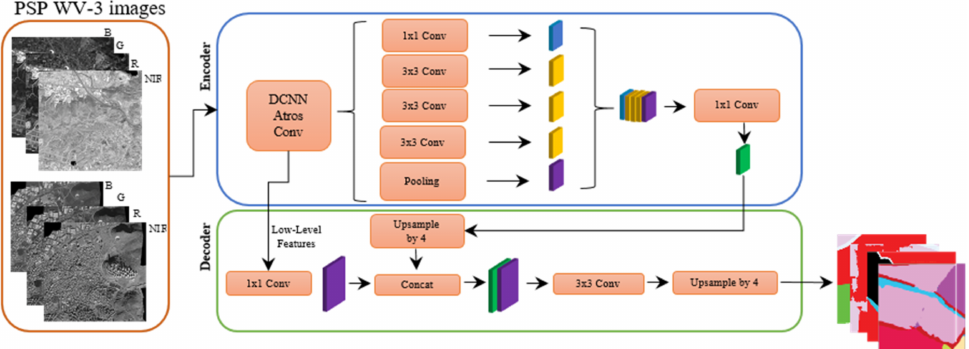
Figure 5. Flowchart of the used deep neural network architecture which follows an encoder–decoder structure with Atrous convolutions that bypasses the low-level features to the